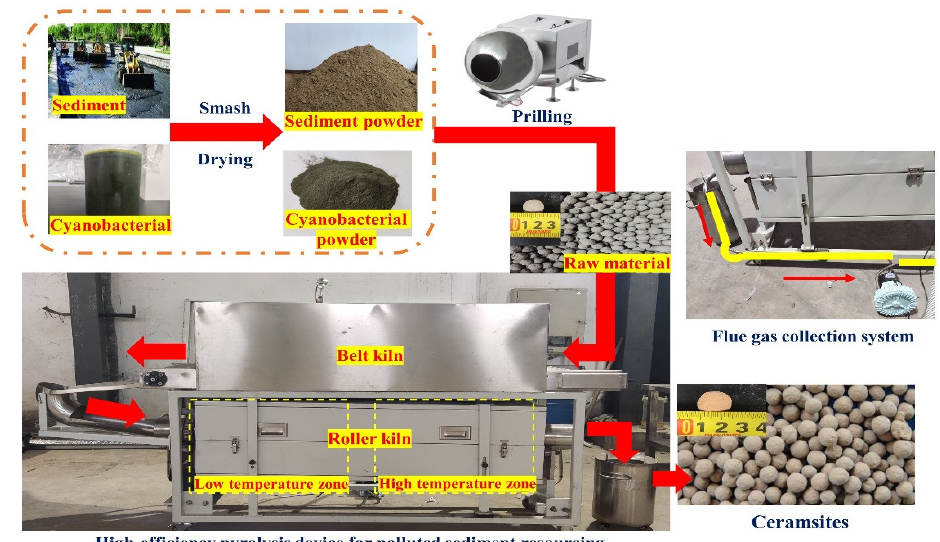
Figure 1. Ceramsite production process flow chart.